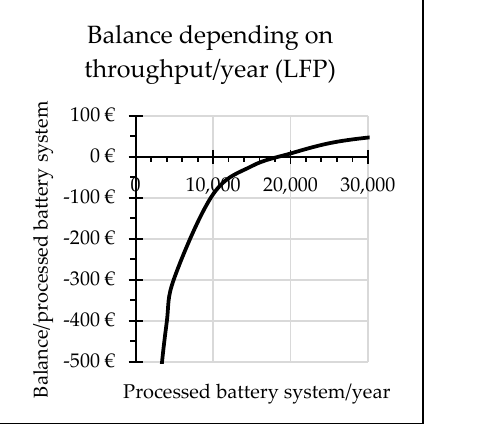
Figure 14. Sensitivity analysis: influence of the battery purchase cost under standard assumptions on the cost–benefit balance.